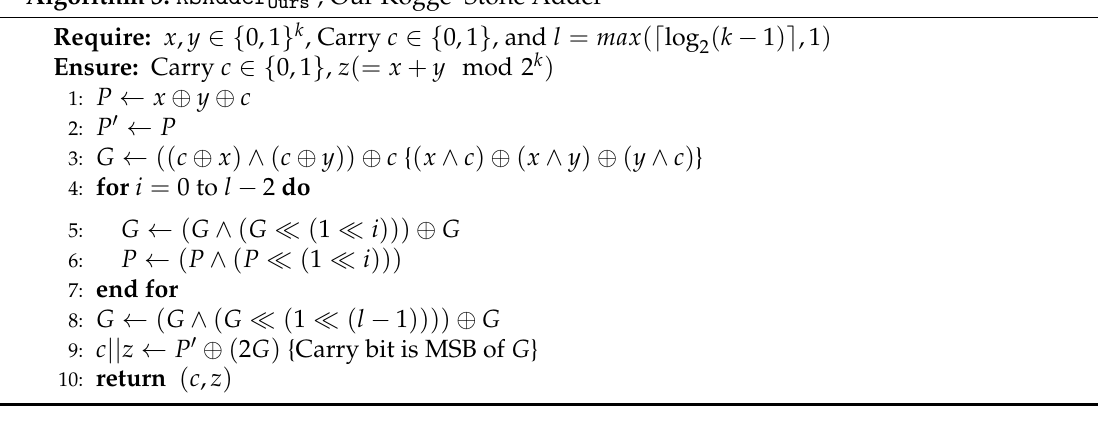
Algorithm 3: KSAdder Ours , Our Kogge–Stone Adder